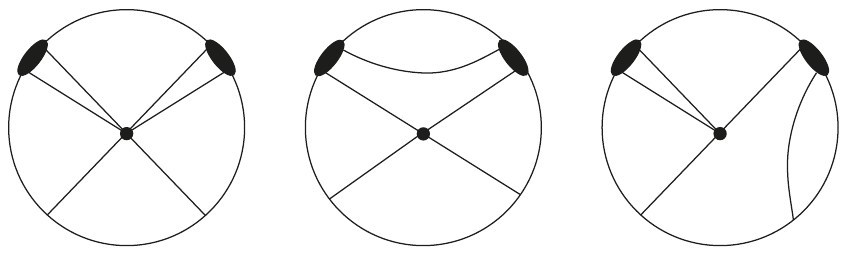
Figure 4 . Connected diagrams contributing to the 4-pt function hO 2 O 2 O 1 O 1 i . There are contribu- tions from both the g 6 and g 4 couplings. Additional diagrams obtained by permuting the external operators must be